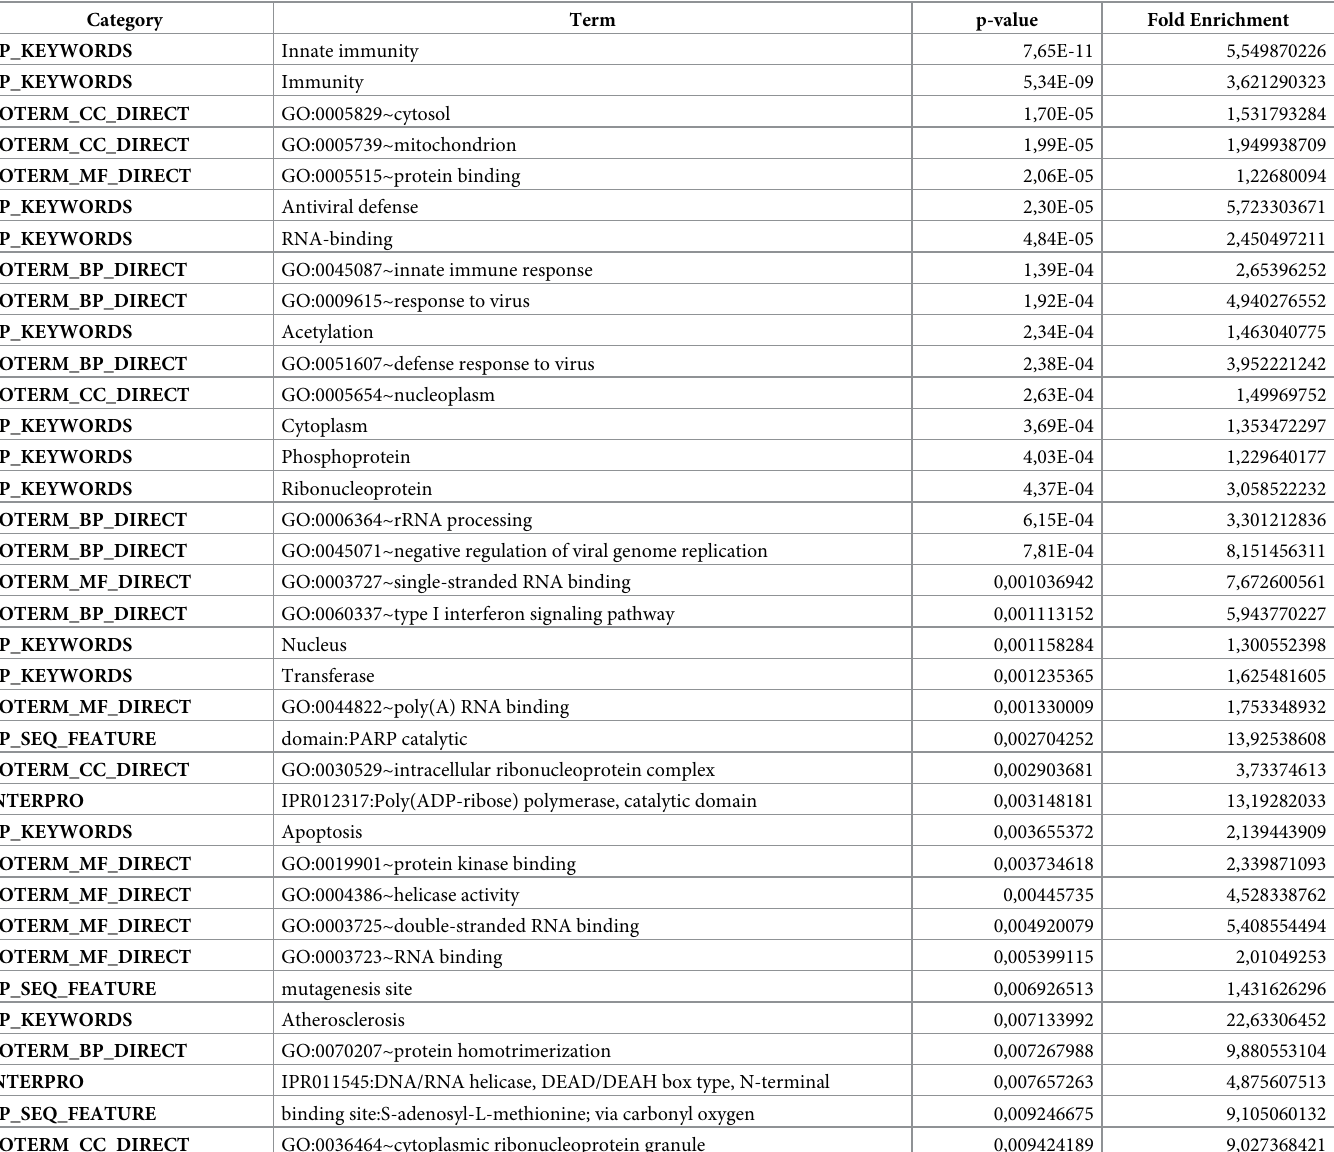
Table 1. Overrepresented biological pathways and gene ontology